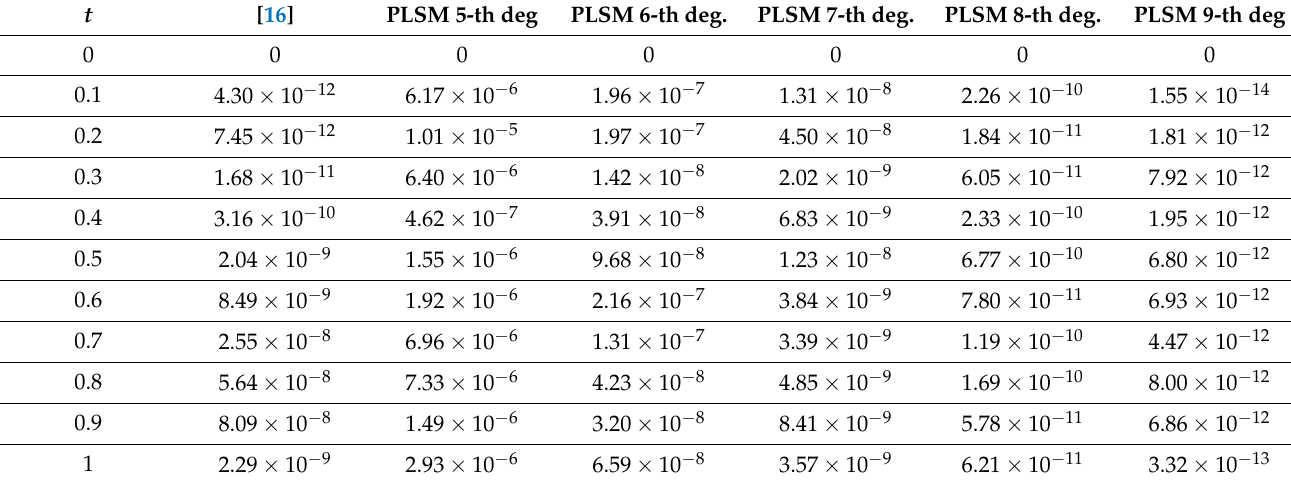
Table 1. Comparison of the absolute errors of the approximate solutions for problem (19) corresponding to α = 1. [16] PLSM 5-th deg PLSM 6-th deg. PLSM 7-th deg. PLSM 8-th deg. PLSM 9-th